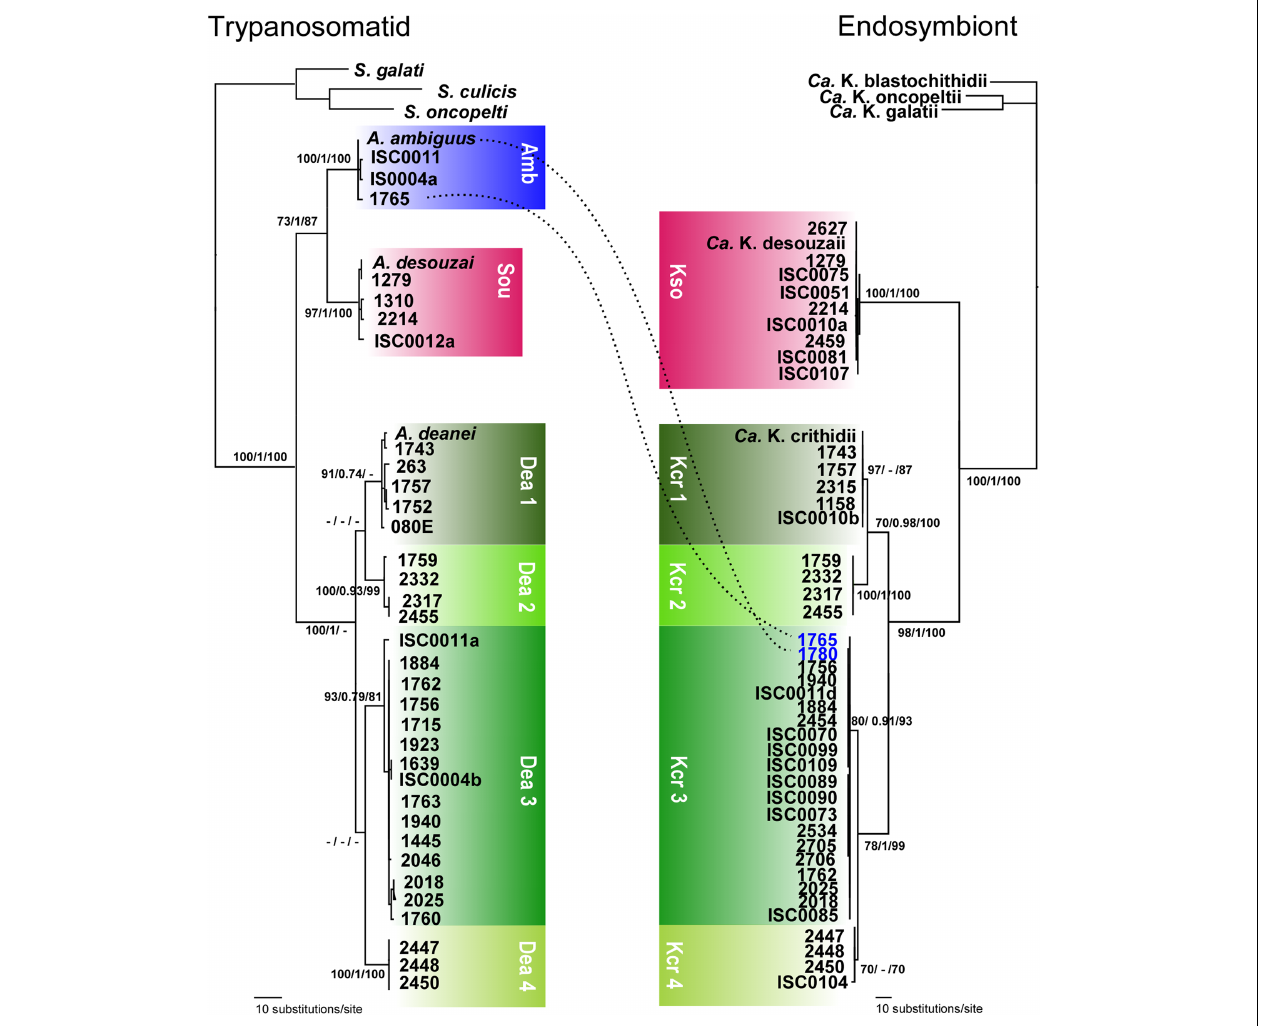
FIGURE 4 | Congruence between Angomonas spp. and endosymbiont phylogenies. Parity analysis between phylogenies inferred using sequences of gGAPDH from the trypanosomatid hosts and GAPDH from their respective symbionts. Host and corresponding symbiont genotypes are represented by matching colors. The dotted line indicates the presence of Kcr3 symbiont of A. deanei in A. ambiguus. Amb, A. ambiguus; Sou, A. desouzai ; Dea1–Dea4, A. deanei genotypes. Kso, Candidatus Kinetoplastibacterium desouzaii symbiont of A. desouzai; Kcr1–Kcr4, genotypes of Candidatus Kinetoplastibacterium crithidii symbiont of A. deanei . Numbers at the nodes correspond, respectively, to P/ML/BI support values ( > 50%) from 500 replicates. GenBank accession numbers of sequences employed in this analysis are shown in Supplementary Table